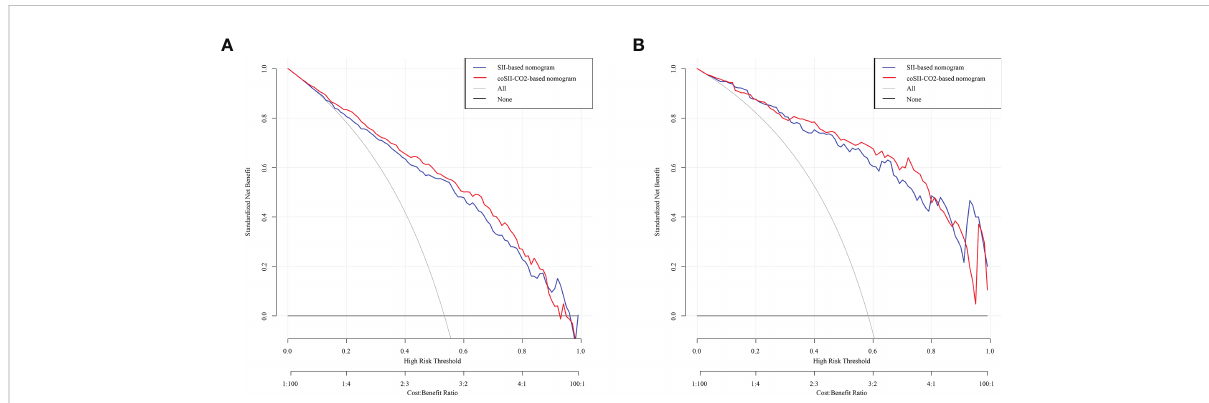
FIGURE 6 Decision curve analysis (DCA) based on SII and coSII-CO 2 in the training and validation groups. (A) Clinical DCA of the training group. (B) Clinical DCA of the validation